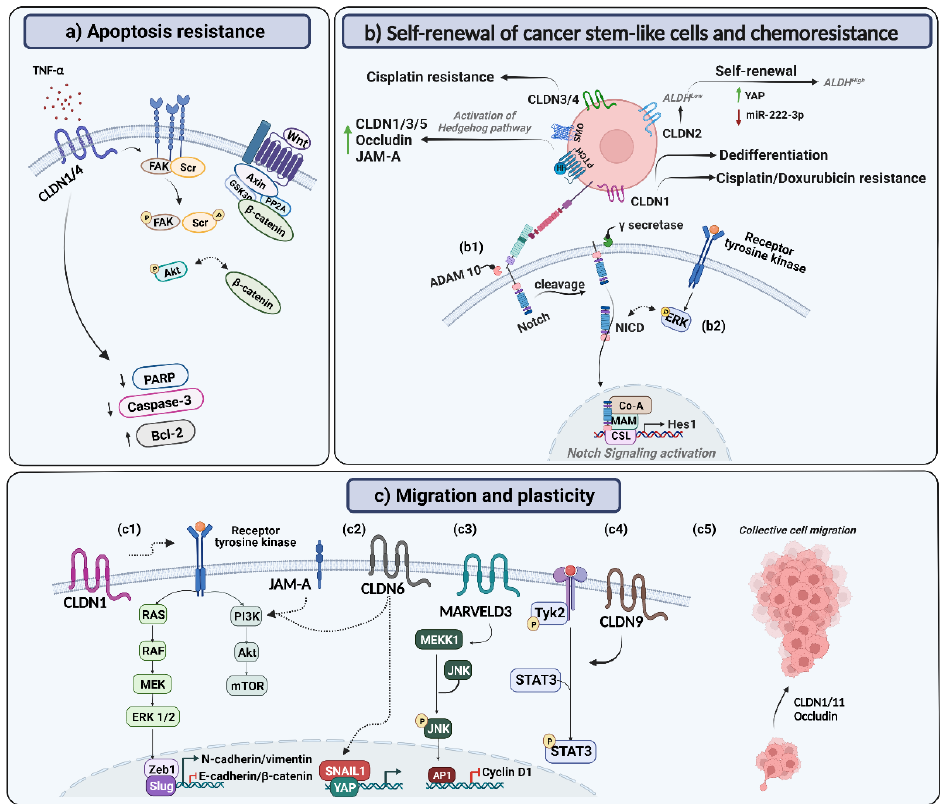
Figure 2. Schematic representation of examples of mechanisms mediated by members of the tight junction protein family during carcinogenesis. ( a ) Tight junction proteins are identified as potential mediators of apoptosis/anikiosis resistance. This is mainly mediated through the upregulation of caspase-3, PARP and Bcl-2, in parallel to the modulation of Src and Akt phosphorylation, coupled to β -catenin overexpression. ( b ) Tight junction proteins are also potential mediators of cancer stem- like phenotype acquisition, where they contribute to self-renewal and dedifferentiation, as well as therapeutic resistance and poor prognosis. In this setting, CLDN1 overexpression increases Notch signaling ( b1 ), in parallel to the induction of MMP-9 expression and p-ERK signaling ( b2 ), as well as through its non-canonical role in regulating Notch/PI3K/Wnt/ β -cateninSer552 signaling. ( c )